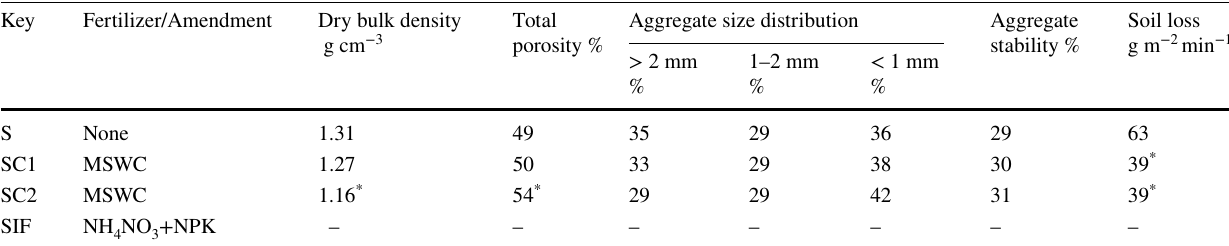
Table 3 Physical properties of the soils after the experiment